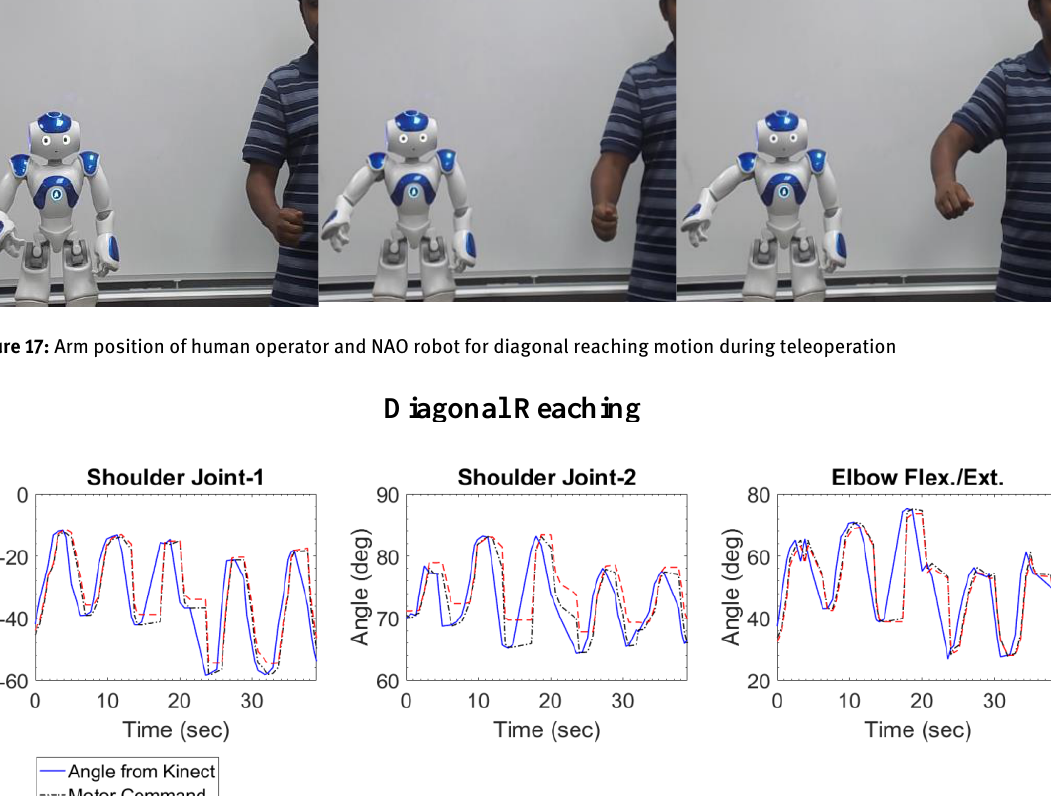
From these experimental results, it is clear that there has a lagging between the human operator’s upper arm joint angle and that of the NAO robot. However, the pattern of the trajectory followed by the NAO robot was the same as that of the human operator. The objective of the developed control approach is to